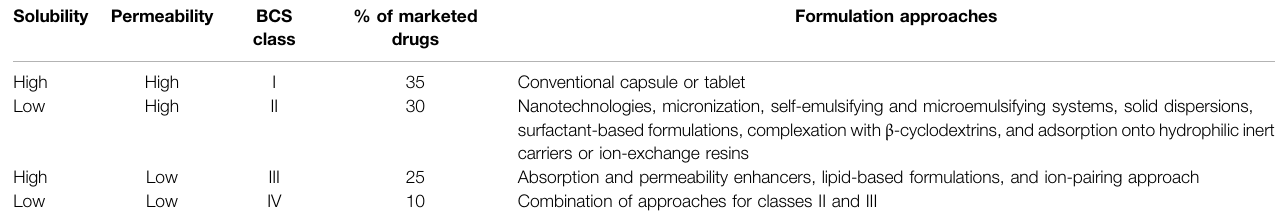
TABLE 5 | Formulation approaches for various BCS class